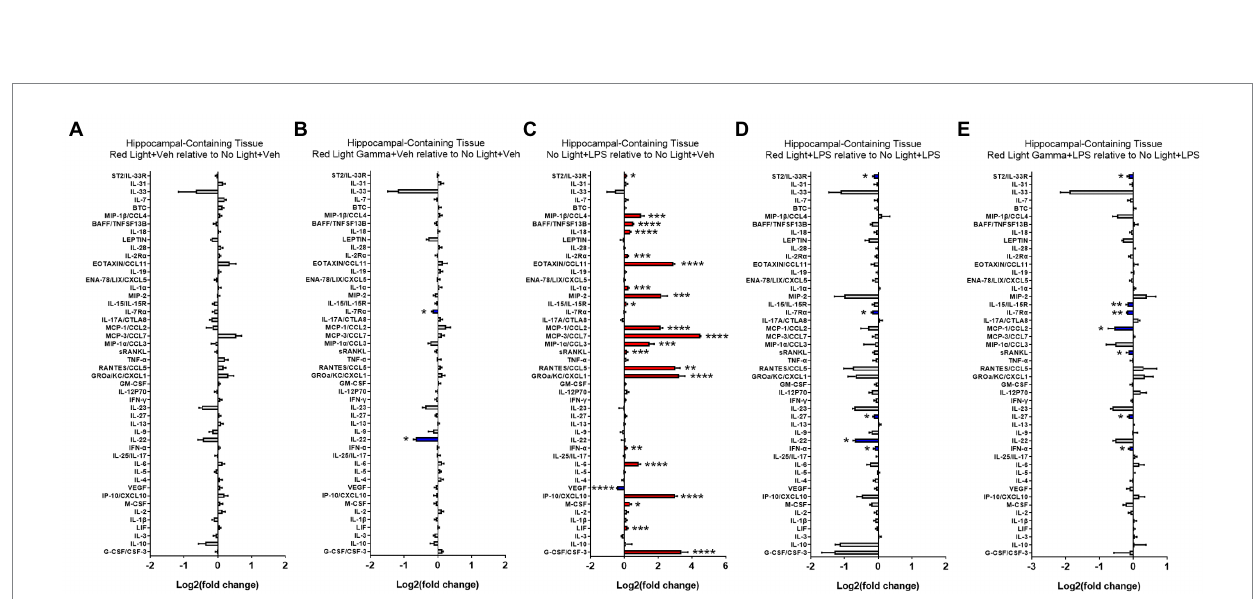
FIGURE 4 Log2 fold change of cytokines in hippocampal-containing brain tissue measured in the Luminex assay depicts the effects of (A) red light, (B) red light gamma, and (C) LPS relative to no light + vehicle, as well as effects of (D) red light and (E) red light gamma relative to no light + LPS. Data are presented as mean ± SEM. * p < 0.05, ** p < 0.01, *** p < 0.001, **** p <